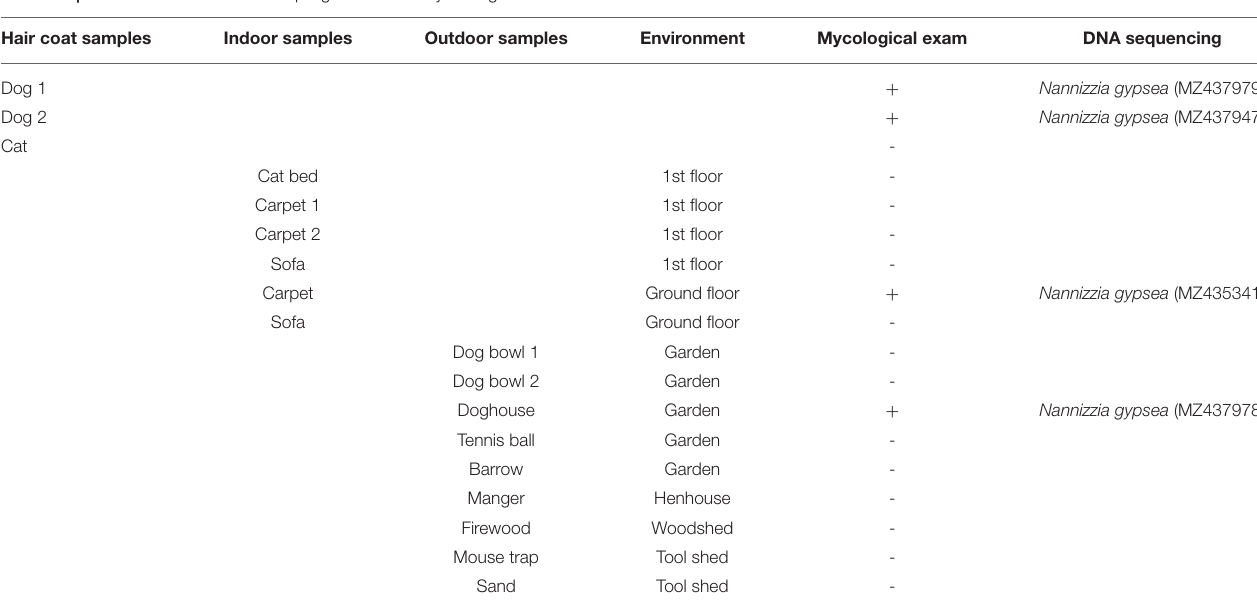
TABLE 1 | Details of veterinarians’ sampling and laboratory